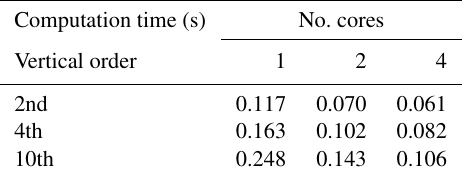
Table 4. Thermal bubble test ((cid:49)x = 20m ) average processor time taken per time step in seconds. Intel Core i7 4000 series under Linux with four computational cores on die (no interconnect hard- ware present). Results show relative scalability for Tempest using Message Passing Interface (MPI) architecture and IMEX partition- ing with variable vertical order of accuracy. The implicit equations are solved using the GMRES with no